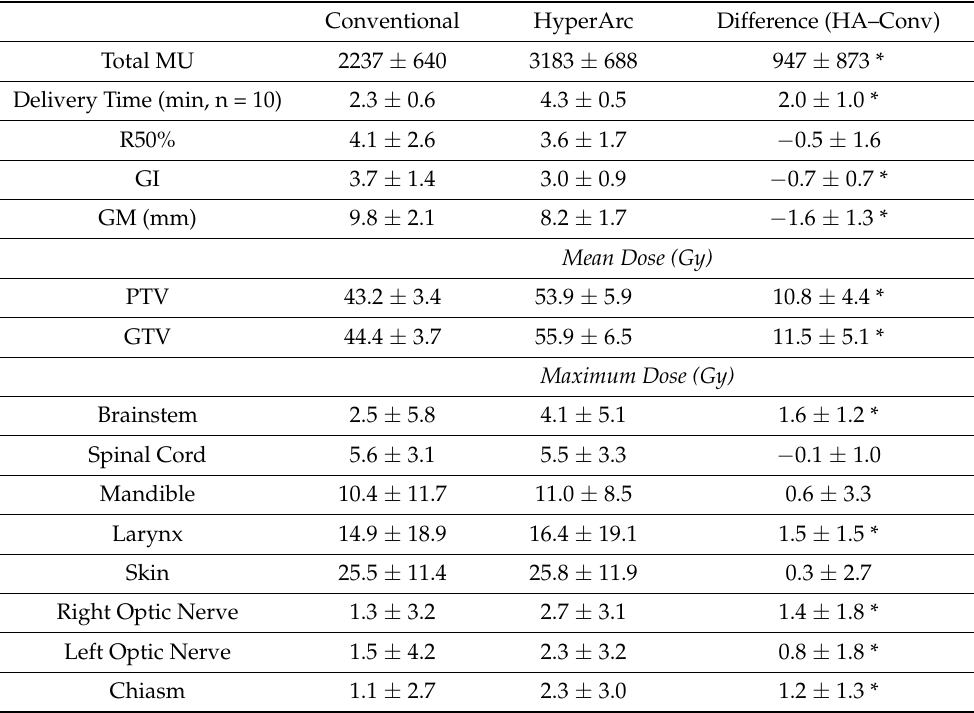
Table 3. Plan metrics and dosimetric statistics for the conventional and HyperArc plans (given as mean ± standard deviation).